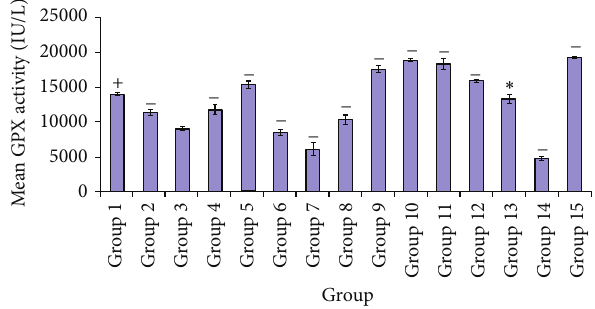
Figure 3: Comparative effect of the various plant extracts on glutathione peroxidase